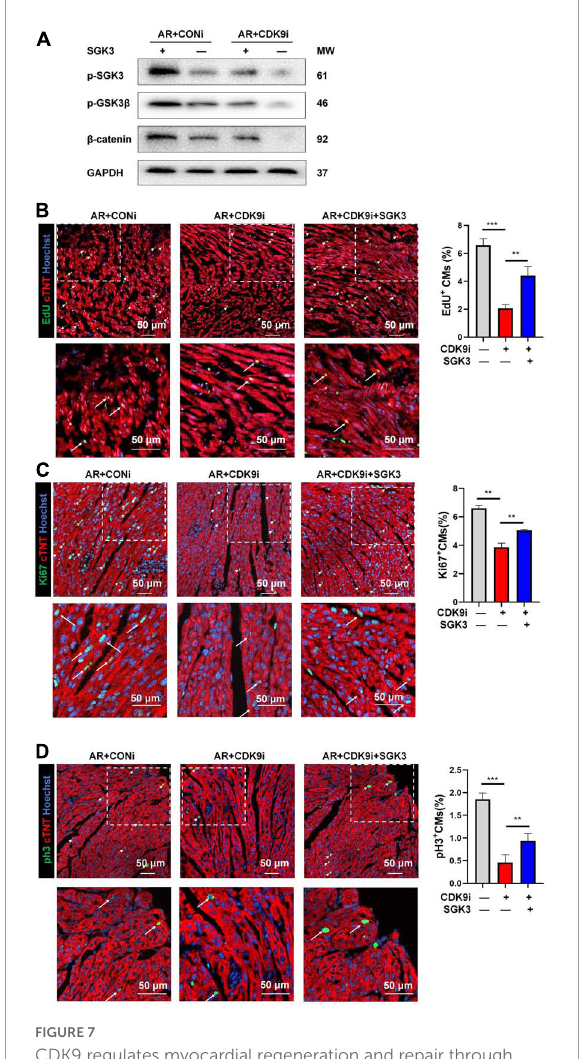
FIGURE7 CDK9 regulates myocardial regeneration and repair through SGK3/GSK-3 β / β -catenin axis in vivo . (A) p-SGK3, p-GSK3 β and β -catenin proteins in neonatal myocardial tissue after intra-myocardial injection with Ad5: cTnT-CDK9 RNAi (CDK9i) and/or Ad5: cTnT-SGK3 (SGK3) after AR detected by western blot. (B–D) CM proliferation in neonatal AR myocardial tissue after intraperitoneal injection with CDK9i and/or SGK3 quantified by immunofluorescence for DNA synthesis (B) , cell-cycle activity (C) , mitosis (D) ( n = 3). Scale bars, 50 µ m; CMs indicates cardiomyocytes, AR indicates apical resection, MW indicates molecular weight; statistical significance was calculated with one-way ANOVA; data are presented as mean ± SEM, ** P ≤ 0.01, *** P ≤ 0.001; each dot indicates a biological